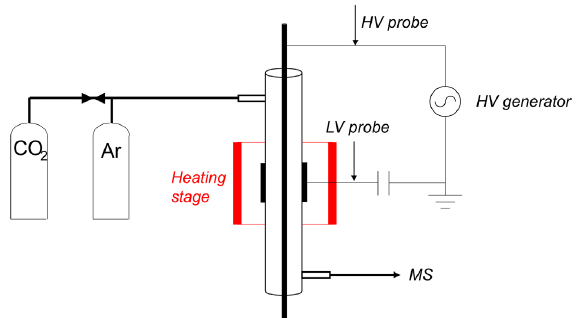
Figure 12. Schematic of the setup to study decomposition of CaCO 3 in Ar plasma. The generator can provide up to 30 kV peak to peak with a frequency range of 23.5 to 66 kHz. The plasma zone is 1 cm long and the reactor is a quartz tube with 6mm outer diameter and 4mm inner diameter. The inner electrode is a stainless ‐ steel rod of 1mm diameter.